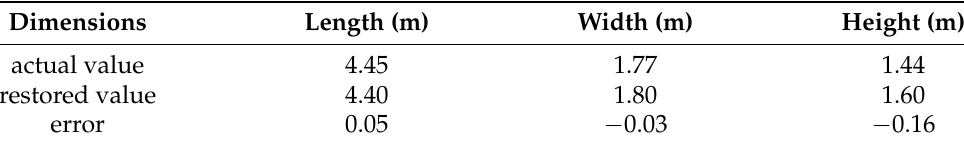
Table 3. Quantitative evaluation of vehicle